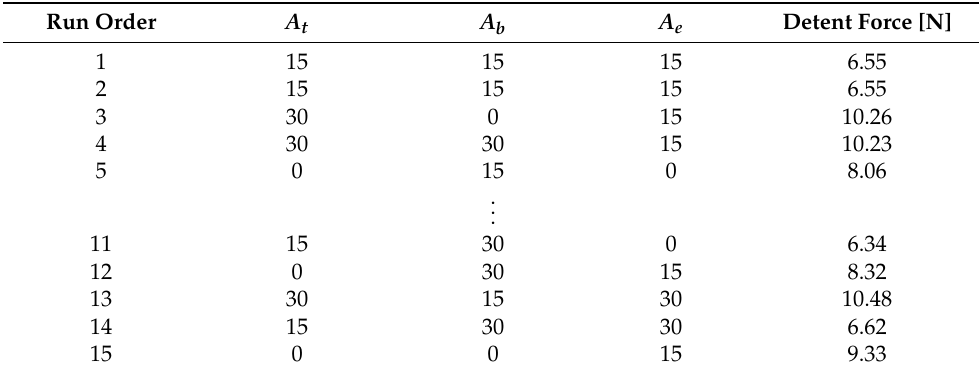
Table 9. Design variables and boundary of the auxiliary teeth.